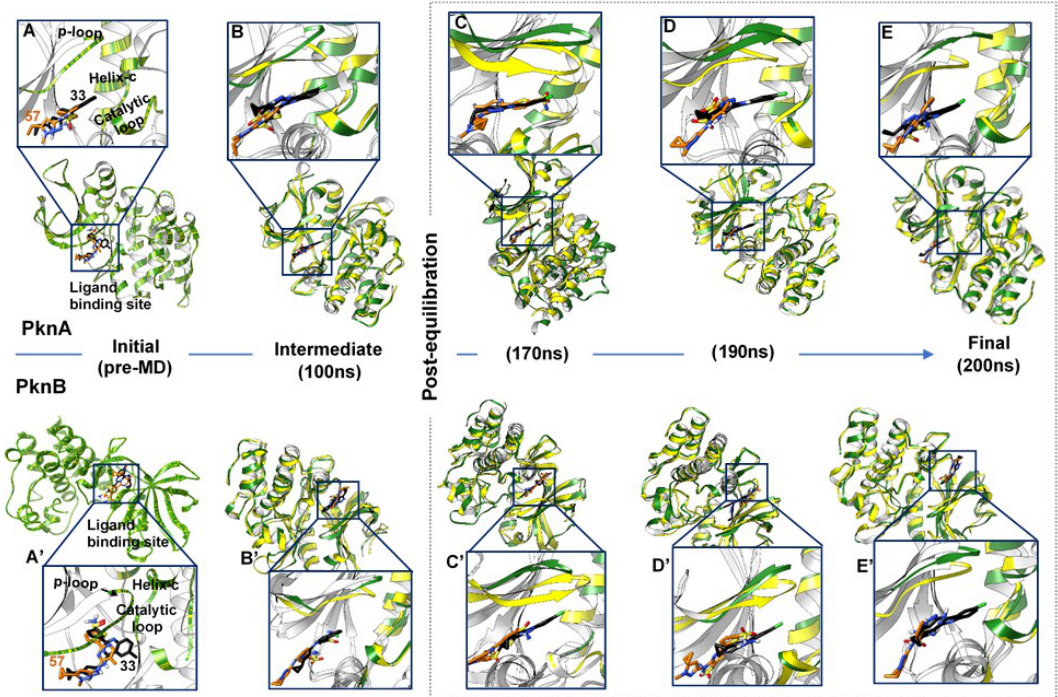
Figure 7. Comparative analyses of systemic alterations induced by the binding activities of compounds 33 (black) and 57 (orange) in PknA- and PknB-NBPs at different time-frames of the simulation run starting from their pre-MD complexes where no alterations in catalytic components occurred yet. Relative motions of PknA P-loop, catalytic loop and helix C regions are revealed in ( A ) – ( D ) from the pre-simulation to the post-equilibrated timeframes while relative alterations in PknB catalytic domain are showed in ( A’ ) – ( E’ ). Orientations of the compounds were also shown along the trajectories.